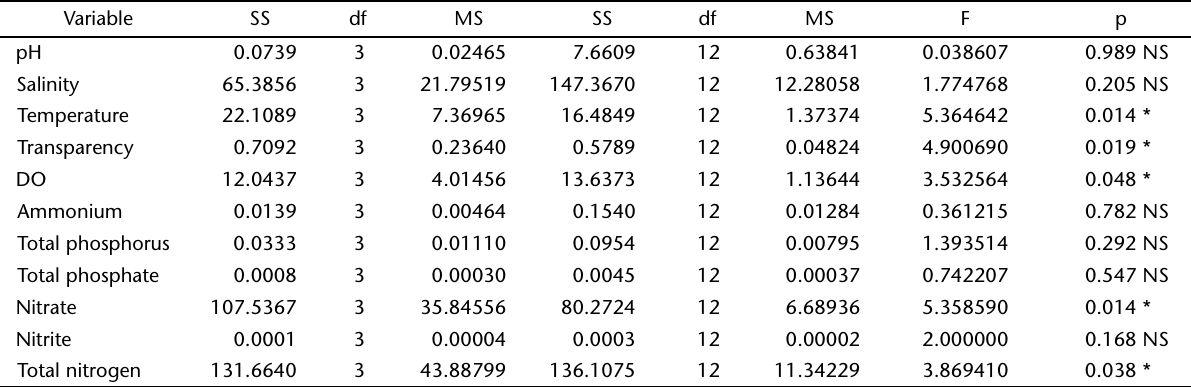
Table I. Analysis of variance. F and p values for environmental parameters related to the four study stations (N = 24 samples/station).